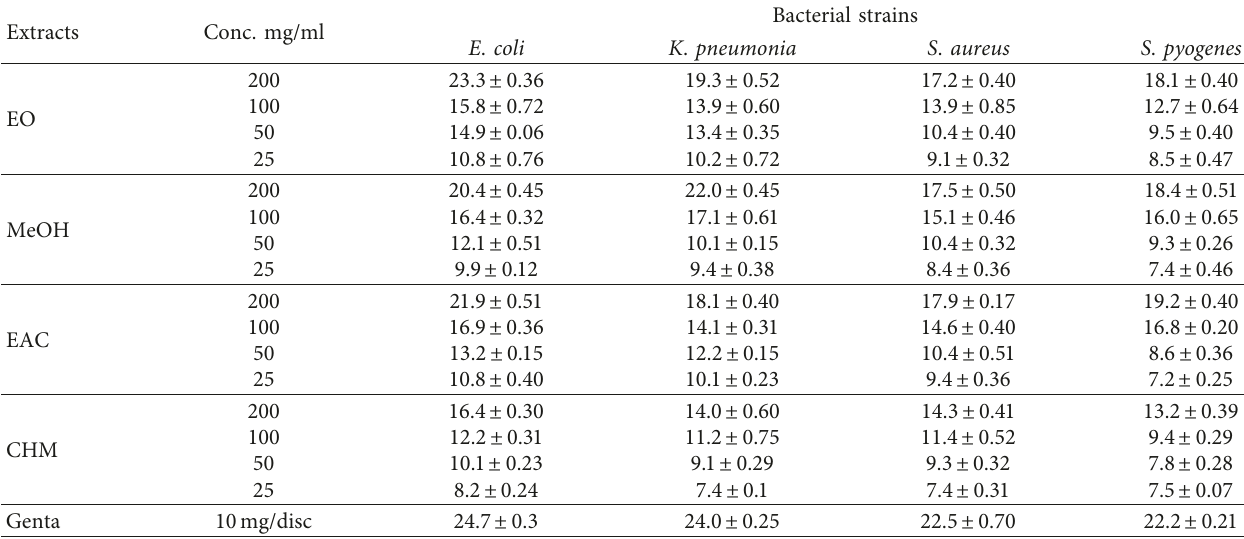
Table 5: Zone of inhibition (mm) of antibacterial activity of the investigated plant in agar diffusion test. Extracts Conc. mg/ml